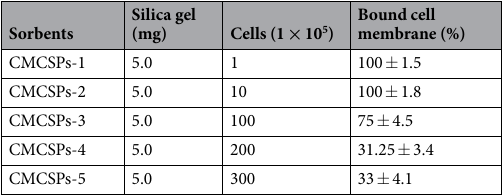
Table 1. Sorbents Compositions of Cell Membrane Bound to Silica Gel a . a Data are shown as mean ±